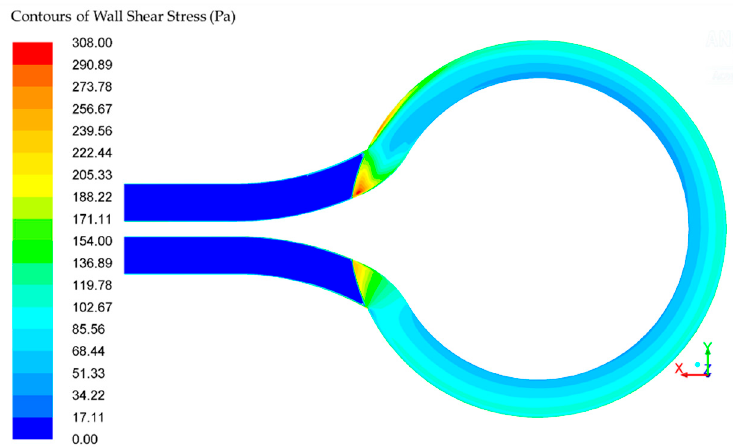
Figure 6. Contours of wall shear stress (Pa).